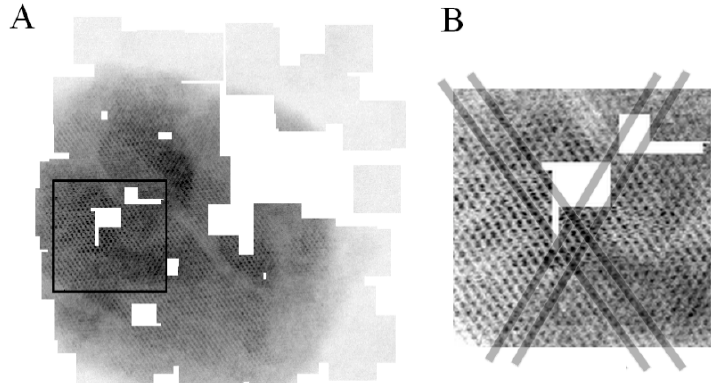
Figure 2. Block-based sparse imaging of an FeO nanoparticle at very high magnification. ( A ) Overlapping blocks (64 × 64 pixels) partially covering the FeO nanoparticle, white areas correspond to uncollected zones. ( B ) Zoom-in on a particular location of the nanoparticle (corresponding to the black box in ( A ) where the crystalline pattern is visible on several overlapping blocks. Thick grey lines drawn along the crystalline lattice highlight the alignment of the atom columns over several blocks.